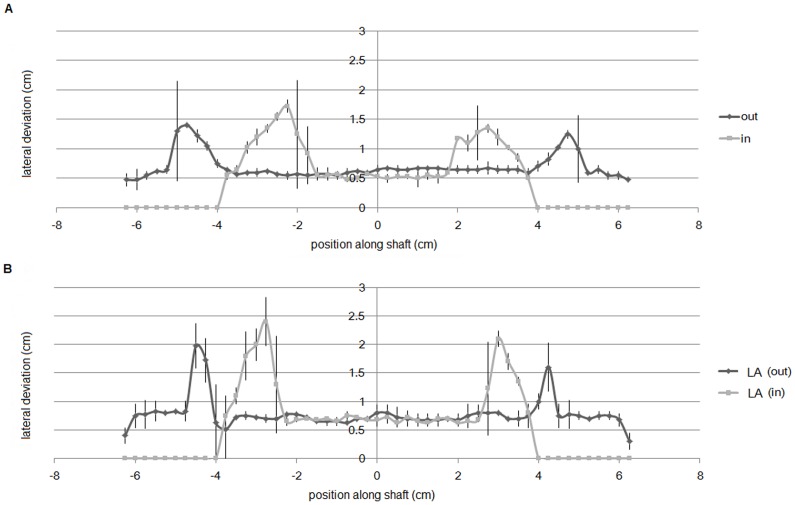
The relationship between lateral deviation and position along the shaft.(a). Wings-out and wings-in configurations; “out” and “in” indicate wings-out and wings-in, respectively. (b). Large angled configurations; “LA (out)” and “LA (in)” indicate wings-out and wings-in large angled configurations, respectively. Two trials were conducted for each of the four configurations (outward, inward, large angled -outward, large angled -inward), and the average values were plotted. Lateral lines indicate error bars.